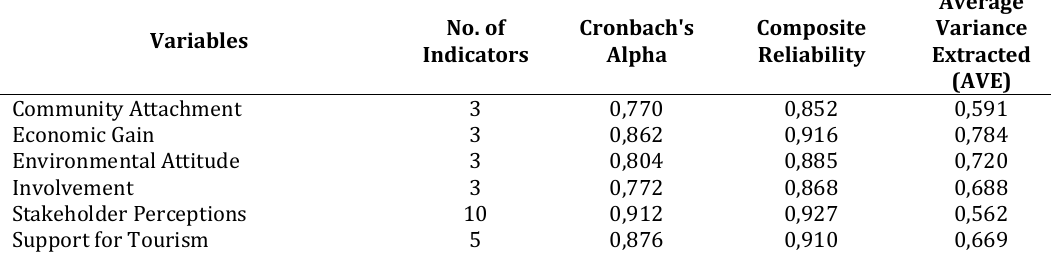
Table 3: Convergent Validity and Reliability